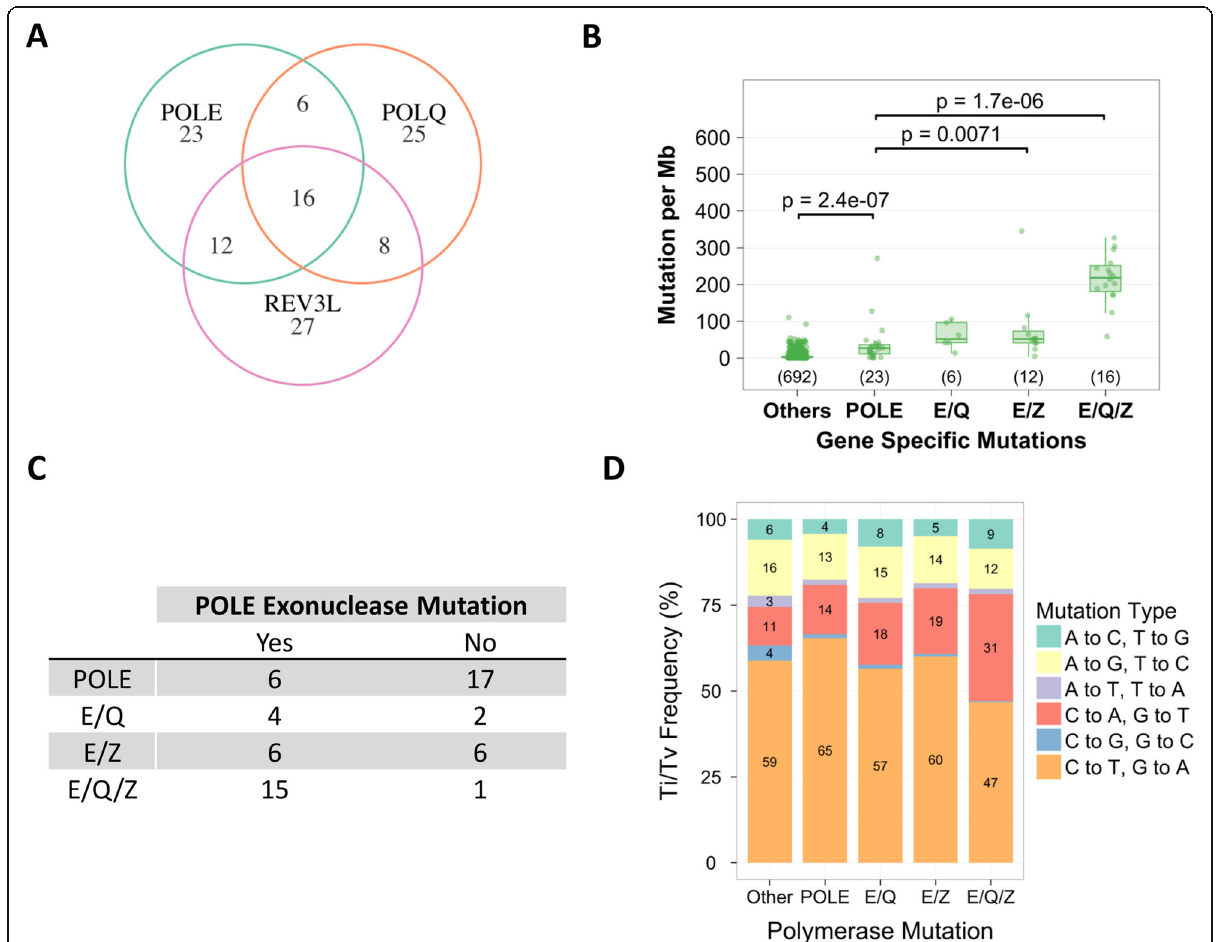
Fig. 2 POLE/Q/Z mutations in colorectal [38] , endometrial (UCEC) and stomach (STAD) cancers. a Venn diagram displaying the number of cases with mutations in 1, 2 or 3 POL genes. b Mutation groups of cases without polymerase mutations (other), or with mutations in POLE only, E/Q , E/ Z and E/Q/Z . The number of cases in each group is listed in parenthesis. The p -value for comparison of POLE and E/Q groups is not significant ( p = 0.056) c Number of cases with mutations in POLE exonuclease domain in various mutation groups. d Percentages the ratio of transitions (Ti) and transversions (Tv) are shown on the Y-axis for CORE, STAD and UCEC. The x-axis shows the mutation